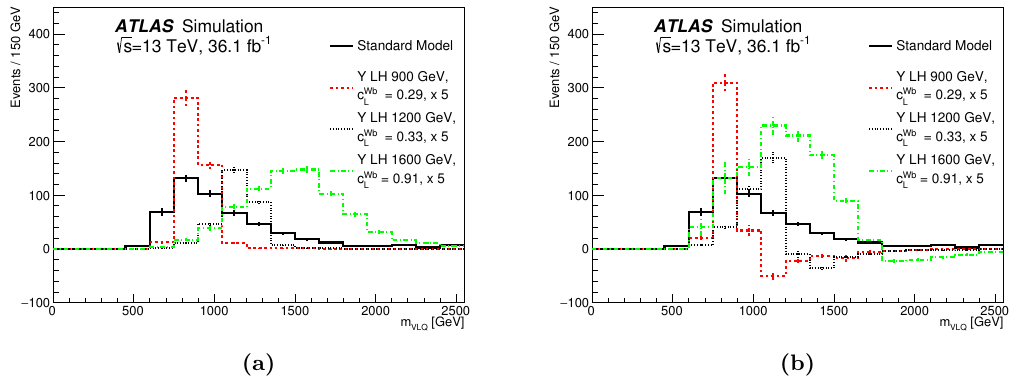
Figure 4. Distribution of VLQ candidate mass, m VLQ , in the SR for three di(cid:11)erent signal masses (a) without and (b) with interference e(cid:11)ects, for a left-handed Y signal with a mass of 900 GeV (dashed line), 1200 GeV (dotted) and 1600 GeV (dash-dotted line) and a coupling of c Wb 0 : 33 and 0 : 91 respectively, together with the total SM background (solid line). The error (cid:25) (cid:25) bars represent the statistical uncertainties. The signal event yield is scaled by a factor of (cid:12)ve. Depending on the coupling and signal mass it is possible that negative entries occur in some bins of the signal-plus-interference m VLQ distribution due to the interference e(cid:11)ect. The distributions for a right-handed and left-handed Y signal without considering any interference e(cid:11)ects are the